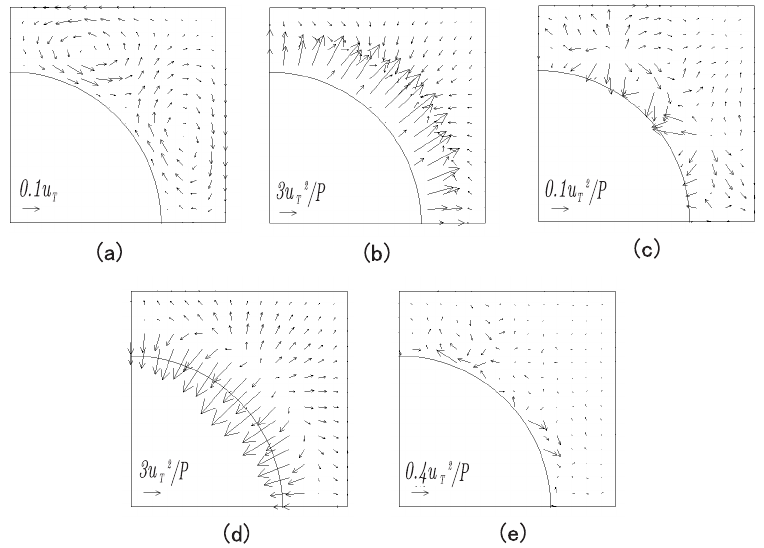
Fig. 5 Mean velocities and components in cross-sectional plane of subchannel:(a) Mean velocities, (b) Pressure gradients, (c) Convective term, (d) Reynolds stress term, (e) Viscous